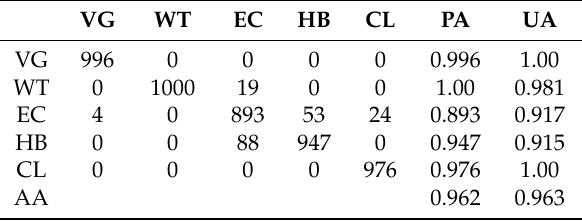
Table 16. Confusion matrix of the SAE in the first area.